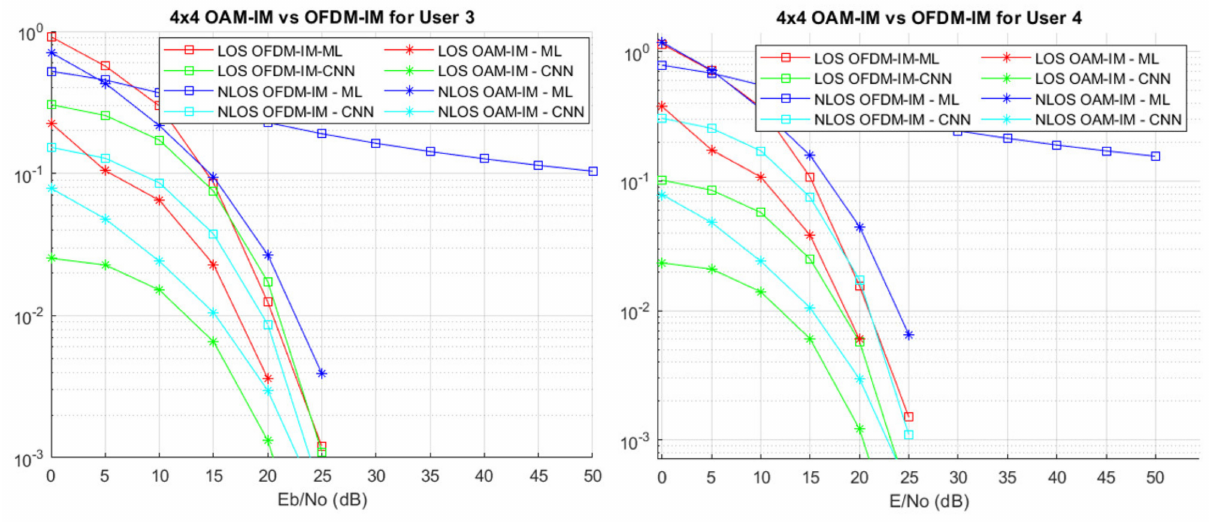
Figure 10. User 3 and user 4 BER of OFDM-IM and OAM-IM for LoS/NLoS VLC